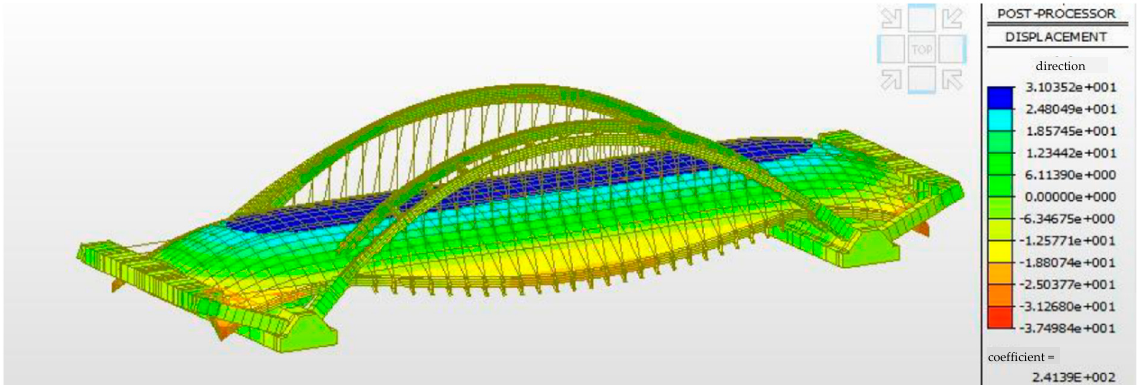
Figure 29. Theoretical deformation of the temperature action of overall cooling at 25 °C (unit: mm).